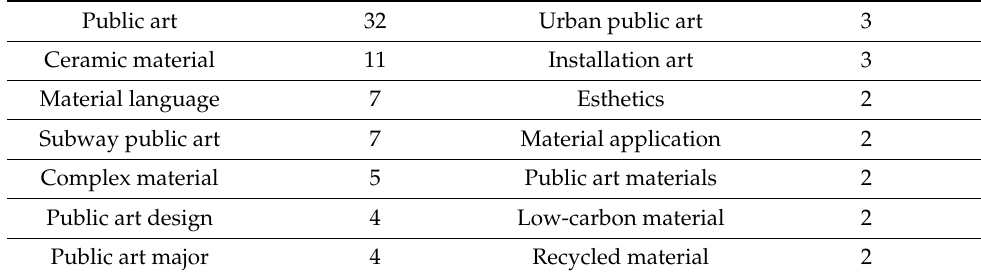
Table 1. Statistics of CNKI on the public art and materials literature